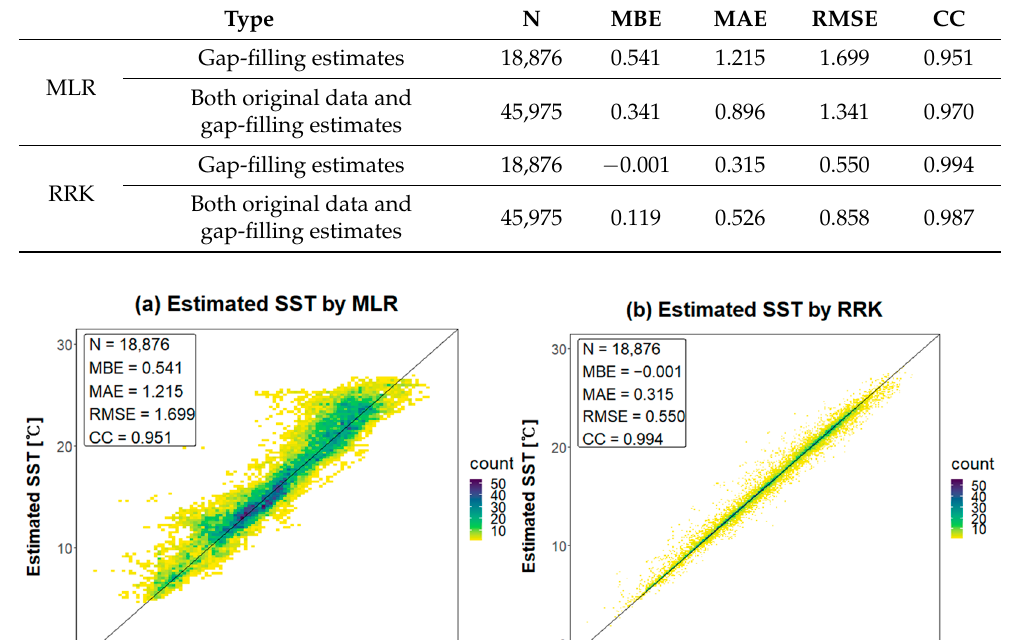
Table 6. Accuracy statistics of GK2A SST estimate by MLR and RRK.